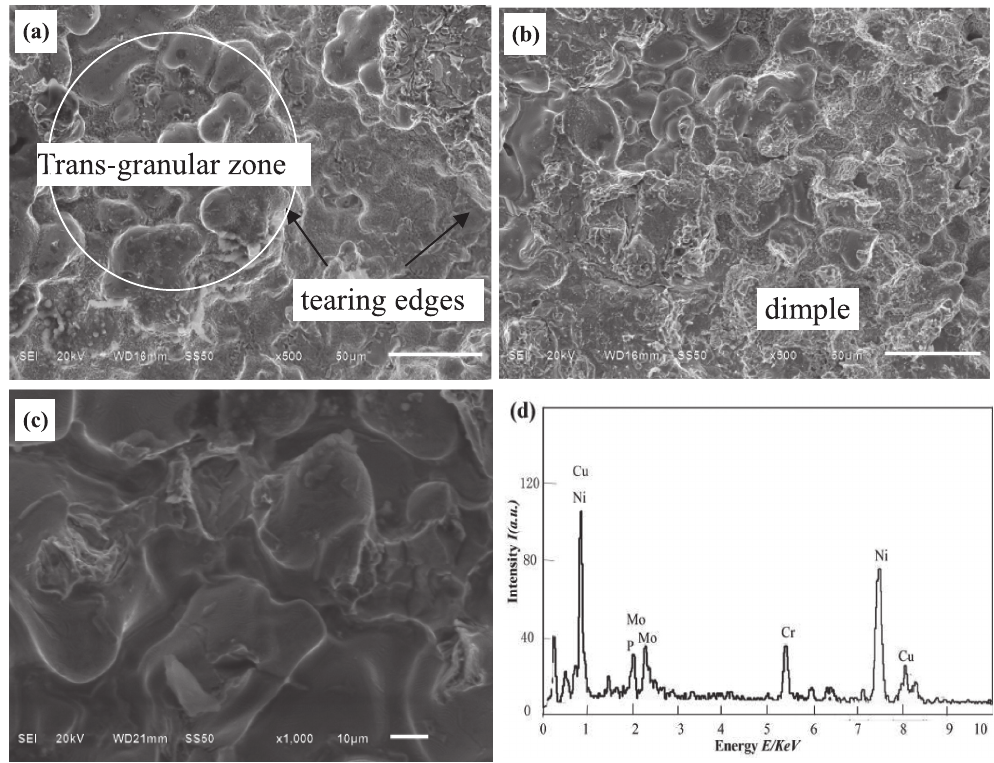
Fig. 4: Shear fracture morphology of Mo-Cu/304 stainless steel brazed joint: (a) trans-granular zone, (b) dimple feature, (c) location of crack initiation, (d) composition of shear